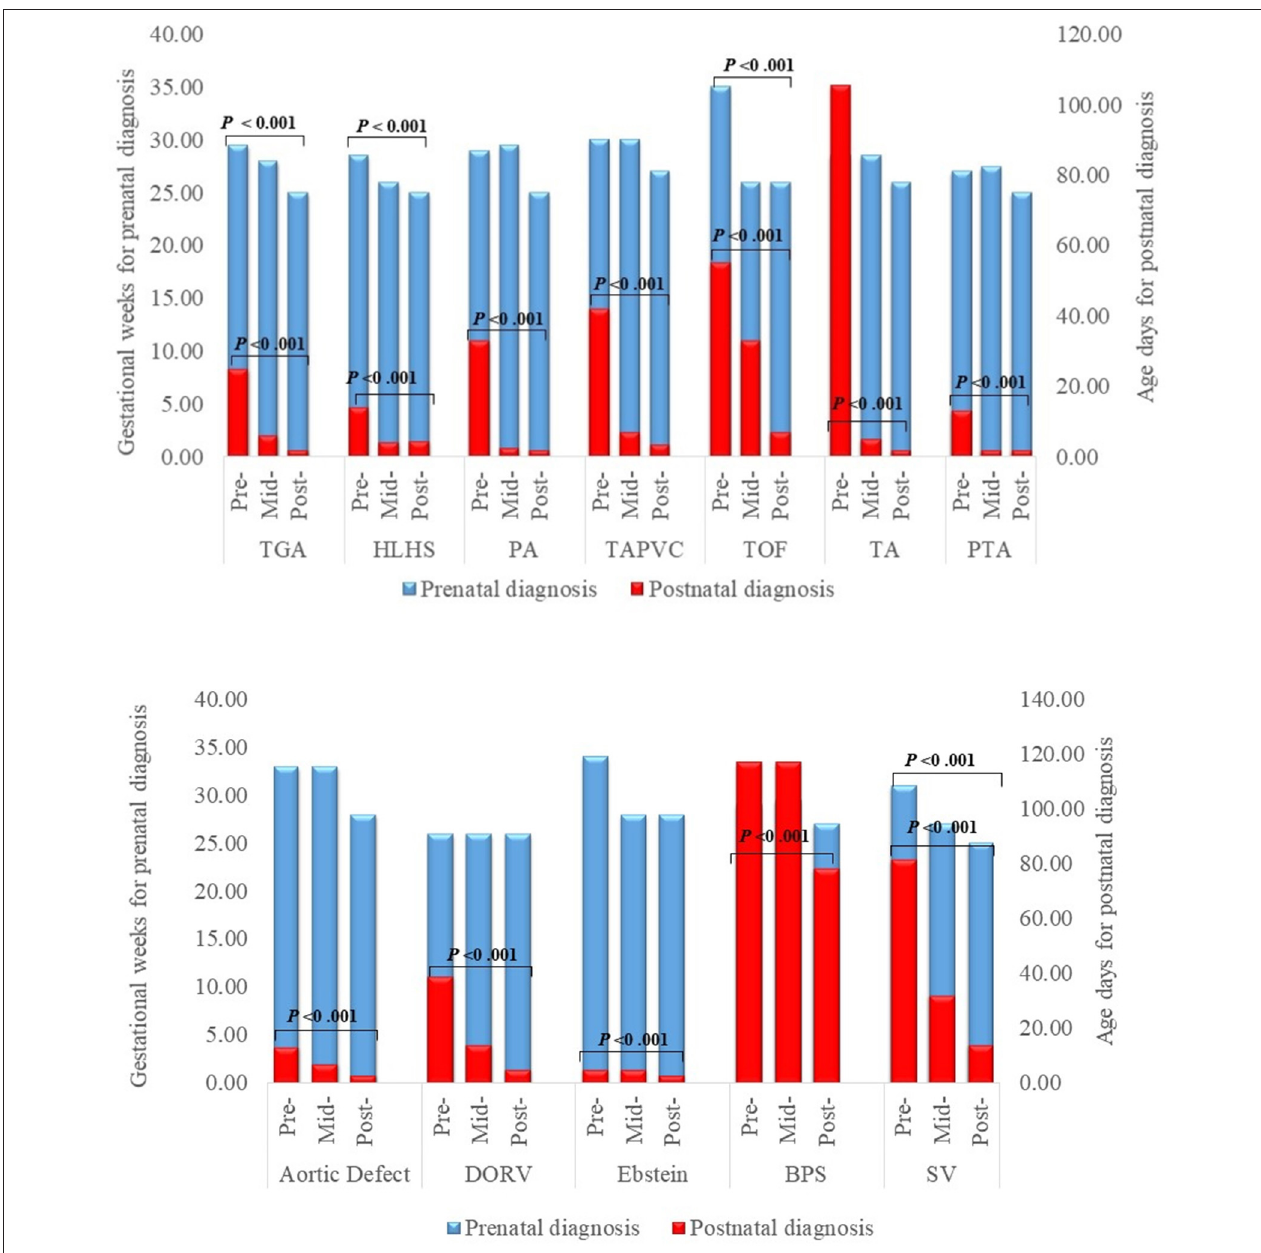
FIGURE 2 | Timing of prenatal and postnatal diagnosis for major congenital heart defects. DORV Double Outlet Right Ventricle, HLHS Hypoplastic Left Heart Syndrome, PA Pulmonary Atresia, PDR Prenatal Detection Rate, PS Pulmonary Stenosis, TA Tricuspid Atresia, TAPVR Total Anomalous Pulmonary Venous Return, TGA D-Transposition of the Great Arteries, ToF Tetralogy of